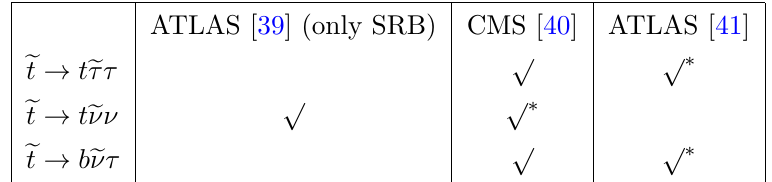
Table 1 . Analyses employed for testing the di(cid:11)erent decay modes. The most sensitive one in each case is tagged with an